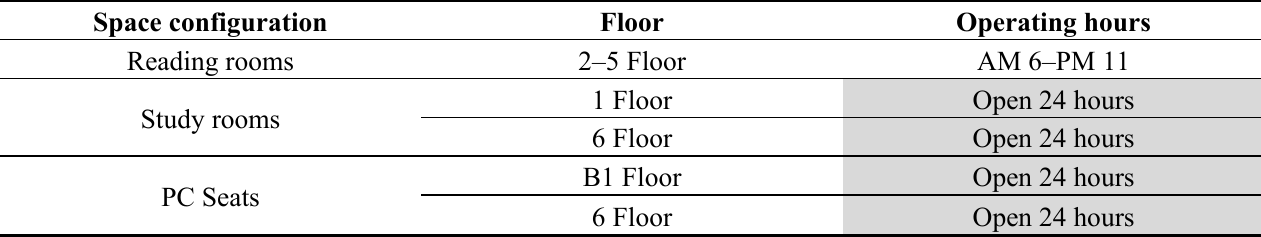
Table A1. Space configuration and operating hours of target library (“Y” university library).